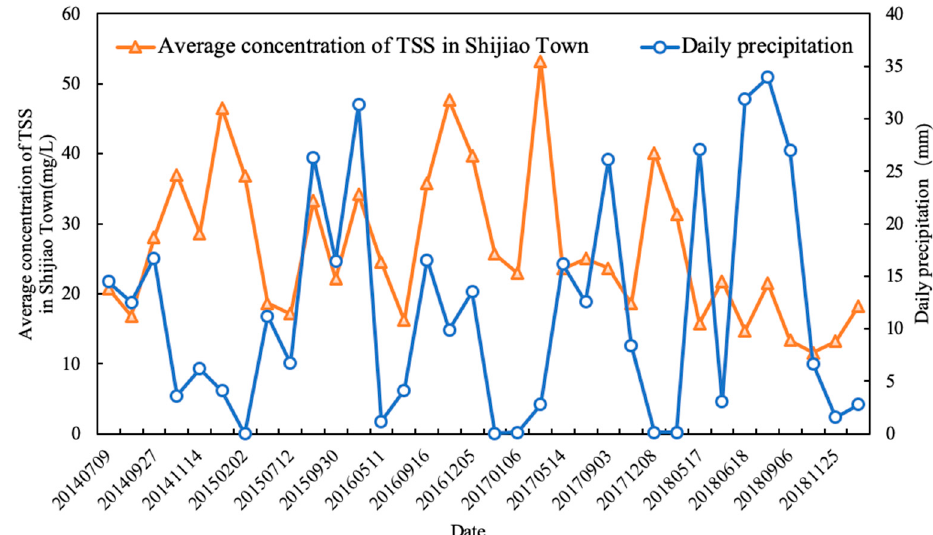
Figure 9. Comparison of time series variation of TSS concentration and daily precipitation in Shijiao Town, where the average TSS concentration is signed by orange triangles and the daily precipitation is signed by blue dots.